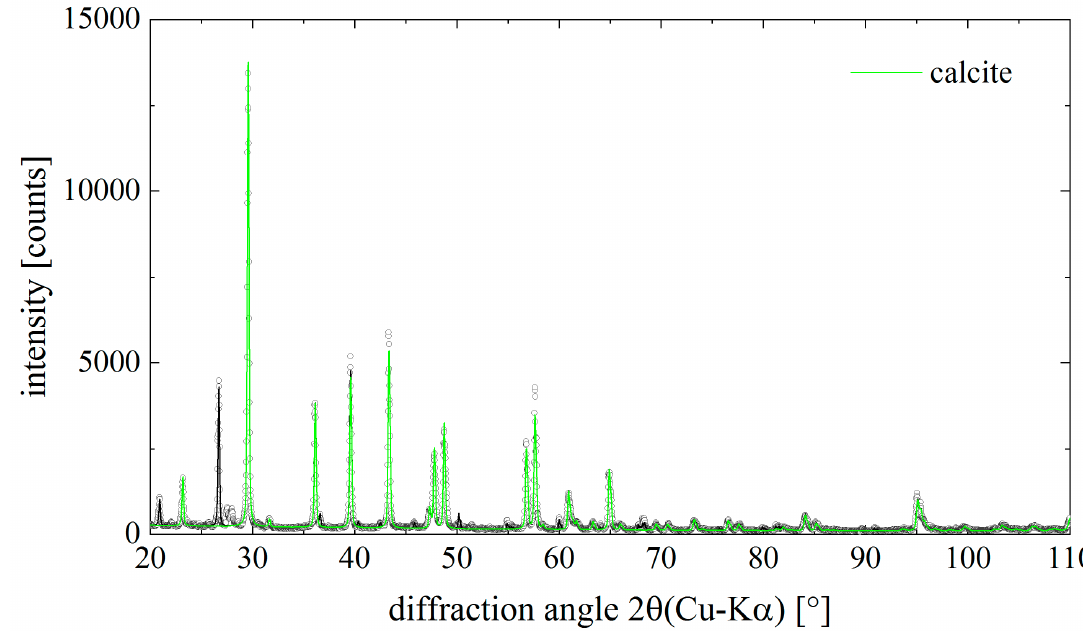
Figure 5. ( a ) low-resolution TEM image of the selected micro-fragment of the I. basta skeletal fiber-containing nanoparticles and ( b ) high-resolution TEM images showing their crystalline nature.